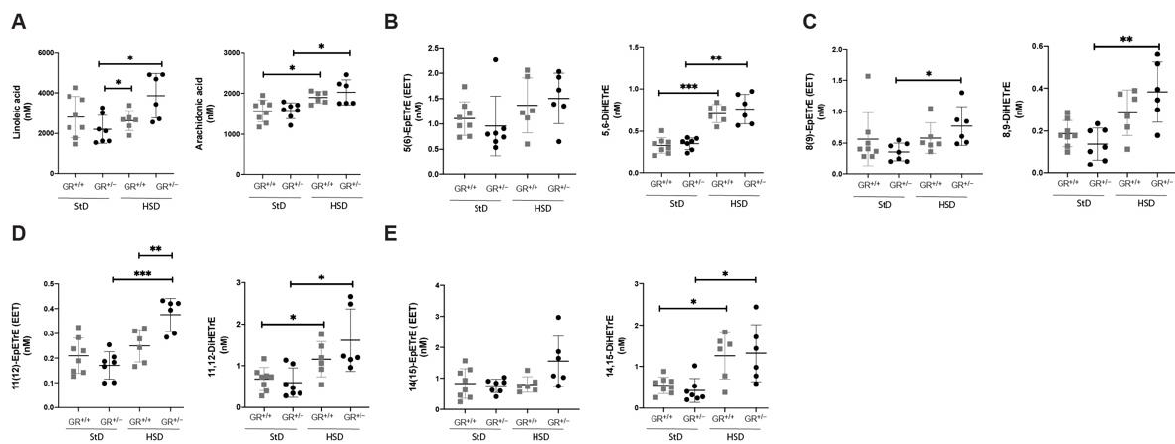
Figure 5. Fatty acid disturbances in arachidonic acid pathway of GR +/− rats. Metabolites of ( A ) lino- leic and arachidonic acid ( B ) 5(6)-EET and 5,6 -DiHETrE, ( C ) 8(9)-EET and 8,9 -DiHETrE, ( D ) 11(12)- EET and 11,12 -DiHETrE, ( E ) 14(15)-EET and 14,15 -DiHETrE measured in plasma of GR +/+ (StD n = 8, HSD n = 6) and GR +/− rats (StD n = 7, HSD n = 6) under standard or high salt diet. Values are indicated as mean ± SEM, and data were evaluated by two-way ANOVA and compared with Tukey test, and differences assessed at * p < 0.05, ** p < 0.01 or *** p < 0.001.